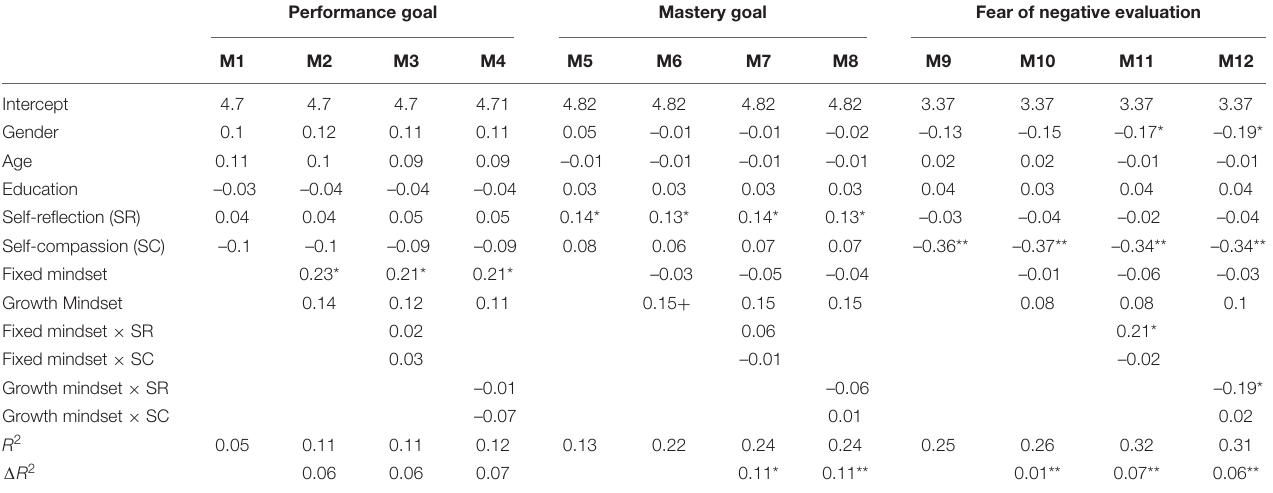
TABLE 3 | Regression for Study 1 ( N =